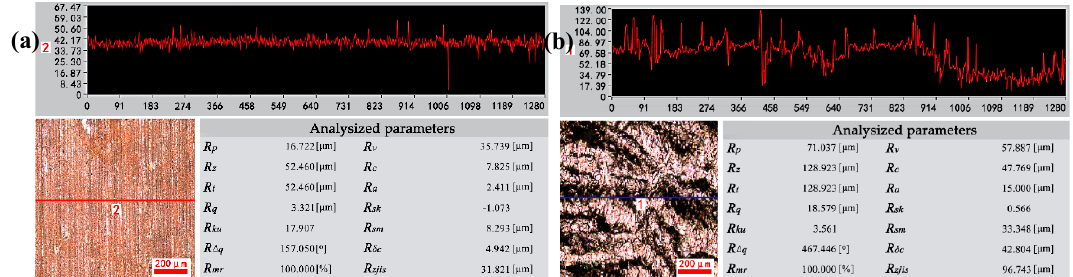
Figure 9 . Surface roughness analyzed by the laser scanning confocal microscope. ( a ) Conform + SNC sample; ( b ) conform sample.